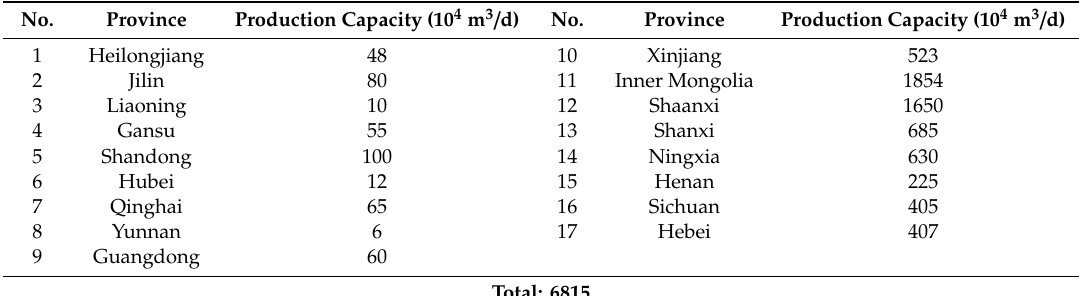
Table 1. Provinces of natural gas liquefaction production and the capacity of each province in China.